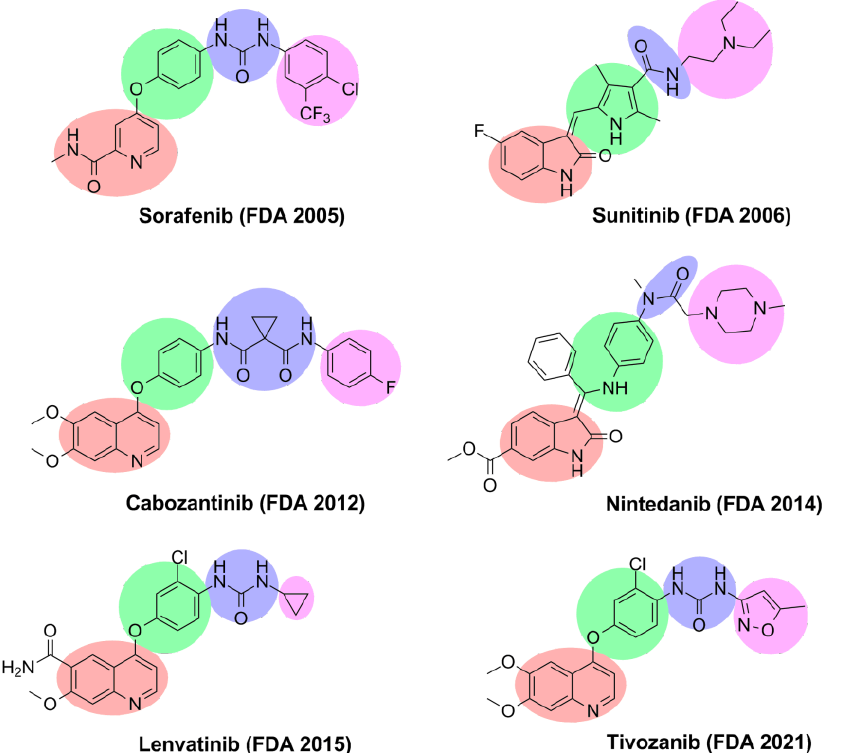
Figure 1. VEGFR-2 inhibitors approved by the FDA.